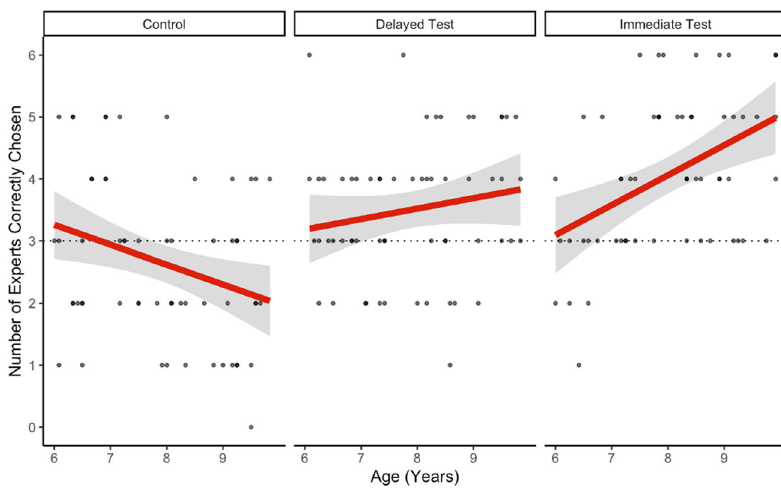
Fig. 2 Expert-detection task performance by age and condition. Ribbons are 95% con fi dence